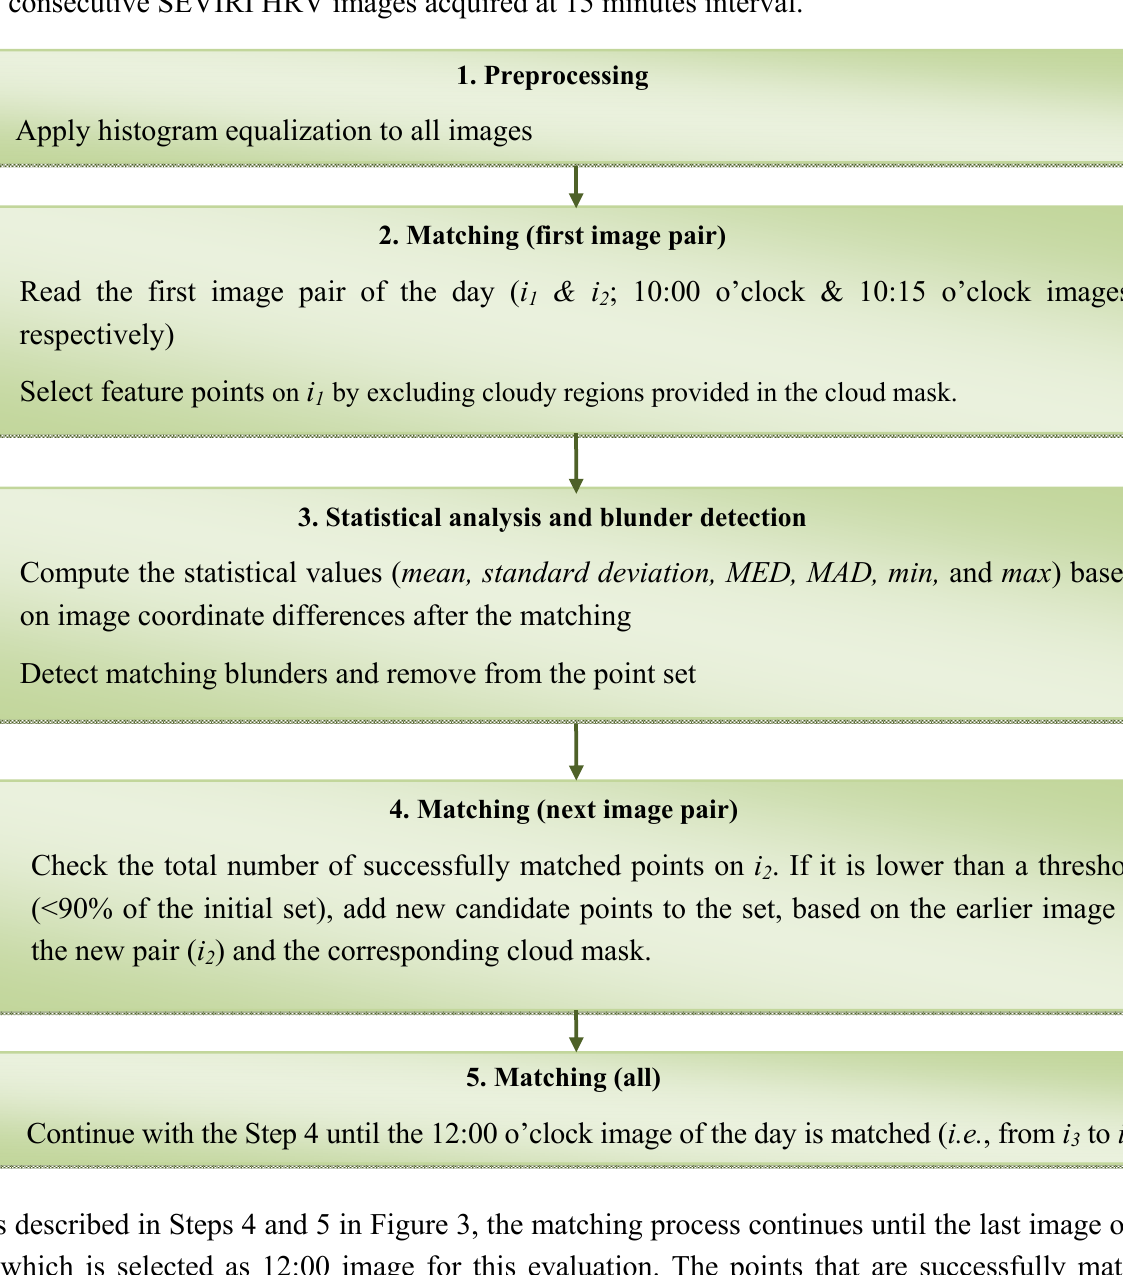
Figure 3. The processing chain for the evaluation of the relative accuracy between consecutive SEVIRI HRV images acquired at 15 minutes